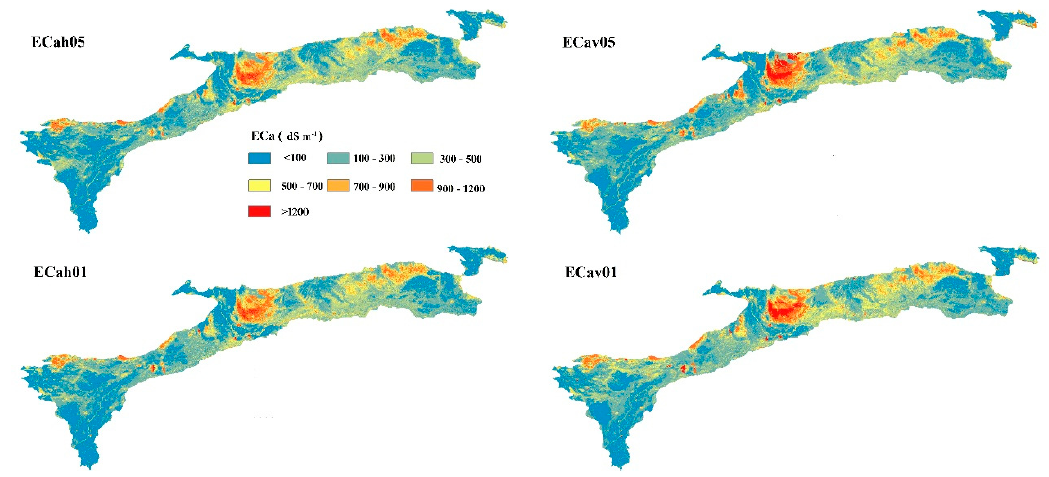
Figure 7. ECa maps derived from the RF model for four EMI coil configurations. Remote Sens. 2020 , 12 , x FOR PEER REVIEW